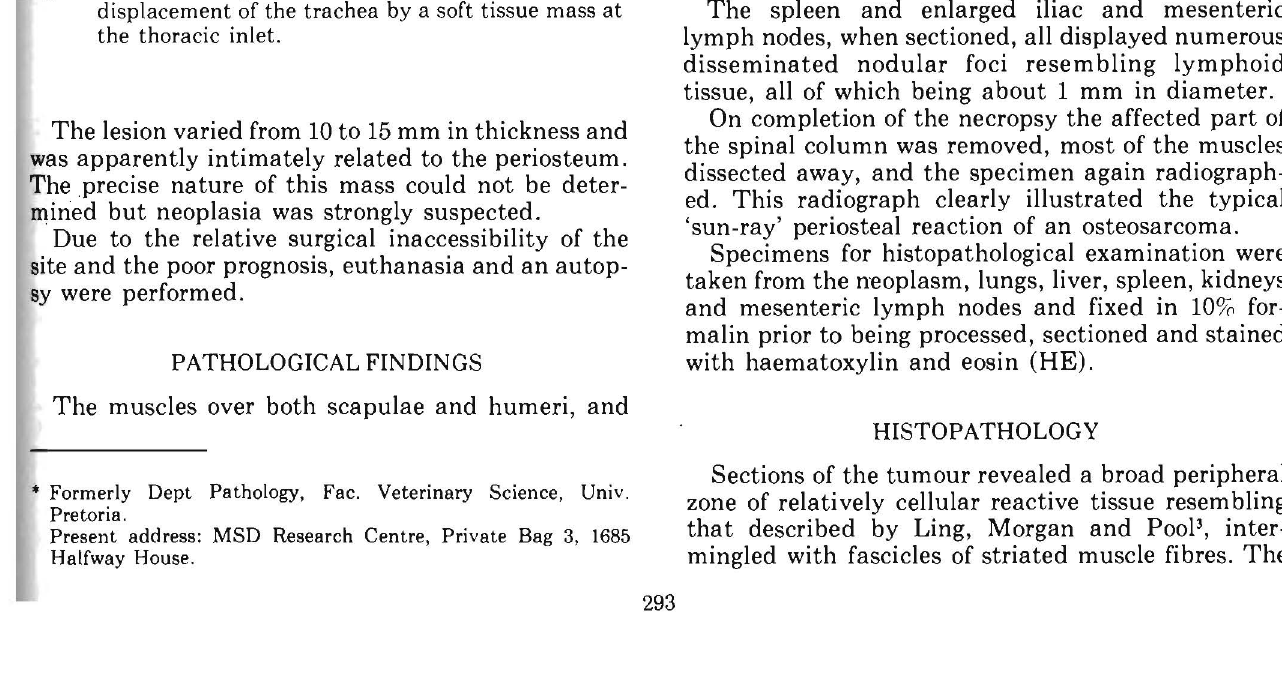
Fig. 2: Tumour mass on the ventral aspect of the vertebral column at the thoracic inlet. The first four ribs on the left hand side have been removed, while the rest are being reflected for better